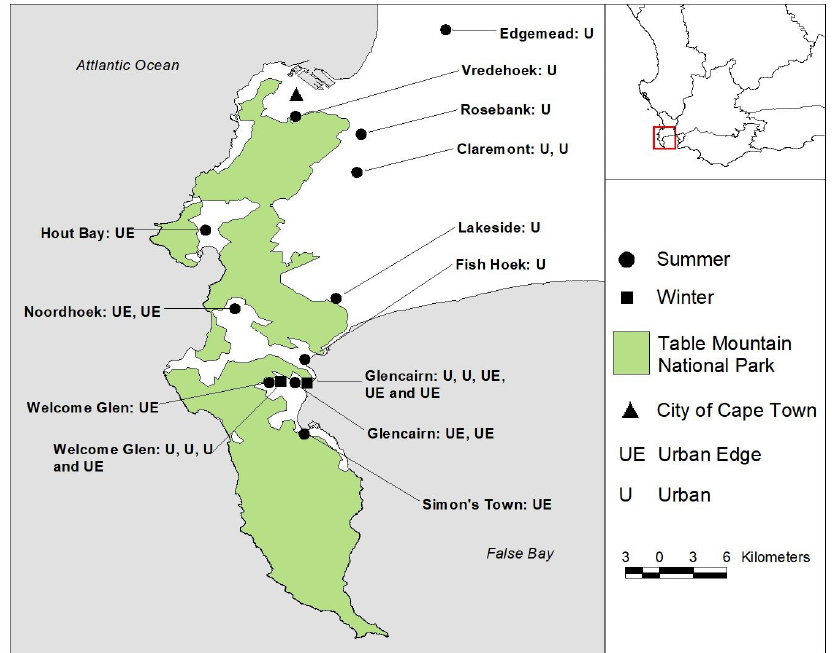
Figure 1. The Cape Peninsula study area, South Africa, showing the extent of Table Mountain National Park (green polygon) and the distribution of 14 summer ‐ tracked cats in Cape Town suburbs and nine winter ‐ tracked cats focused on the Glencairn/Welcome Glen area. Urban ‐ edge (UE) and urban (U) cats are distinguished.